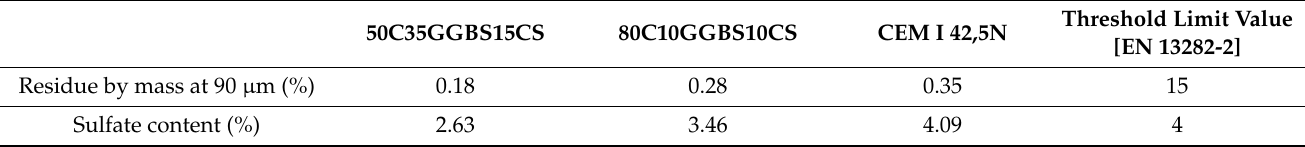
Table 8. Binder residue by mass at 90 µ m and sulfates contents.